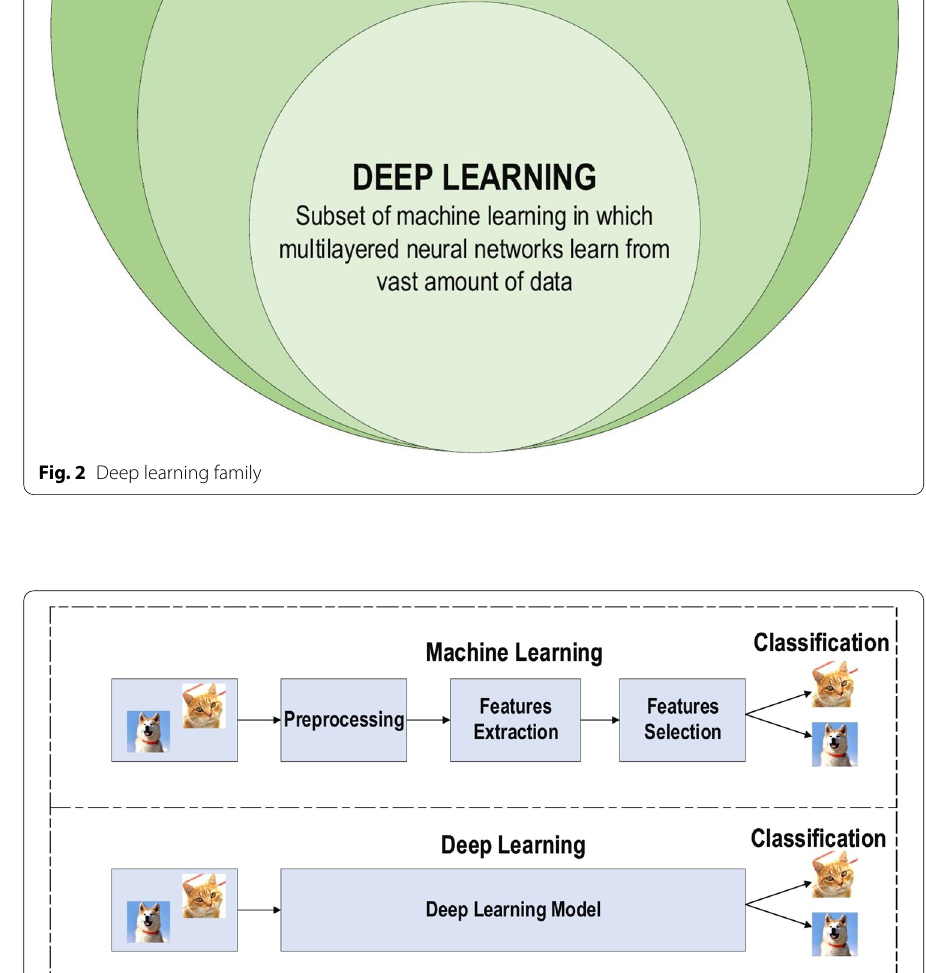
Fig. 3 The difference between deep learning and traditional machine